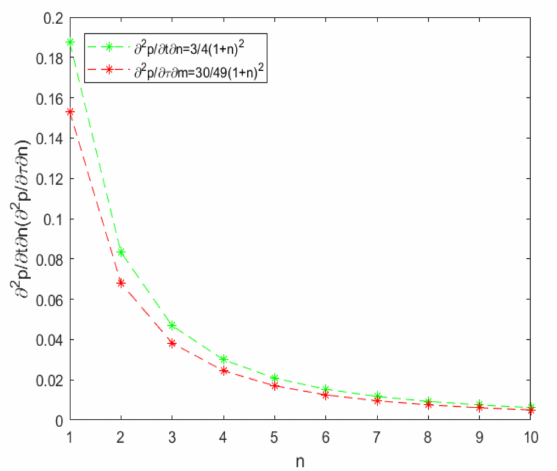
Figure 14. Relationship between rates of change for products in downstream countries with re- gard to rates of change in a specific duty and ad valorem tax and the degree of concentration in upstream